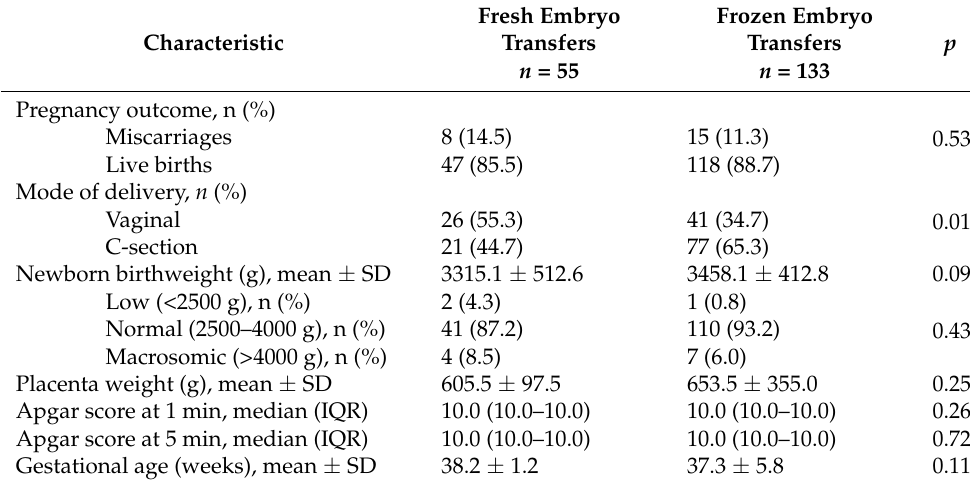
Table 5. Pregnancy outcomes of IVF embryo transfer cycles.